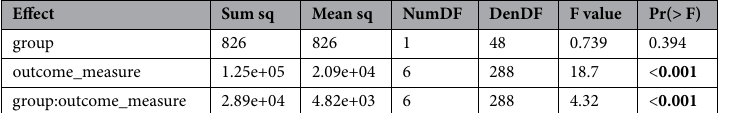
Table 2. Split Steps to Plateau ANOVA: results of the mixed model for the rate of adaptation of the gait parameters at the point at which plateau occurred for the condition. Bolded p-values indicate significance of the corresponding factor. The group factor refers to the younger and older adult categories and the outcome measure factor refers to the different gait